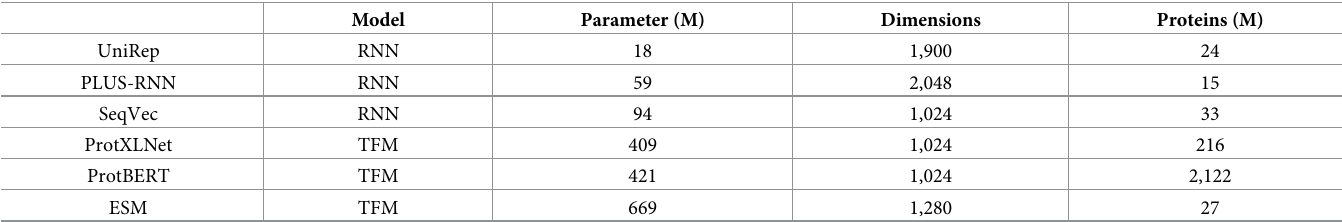
Table 2. Pre-trained protein language